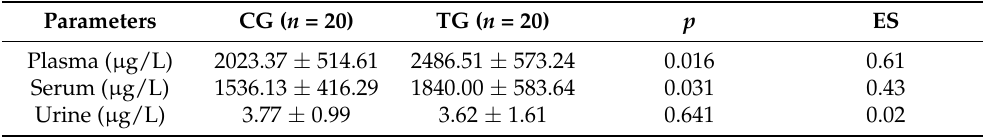
Table 5. Fe concentration in extracellular